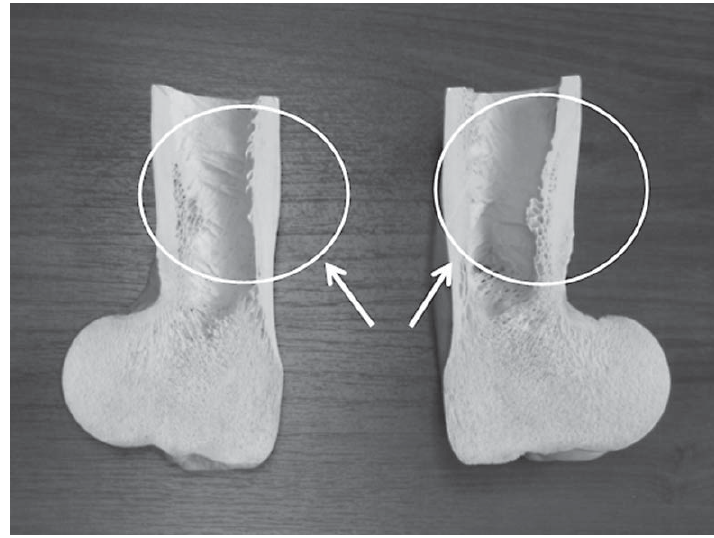
Fig. 9. Longitudinal section of distal part of the humerus (medial and lateral half) showing the area with the highest cortical layer